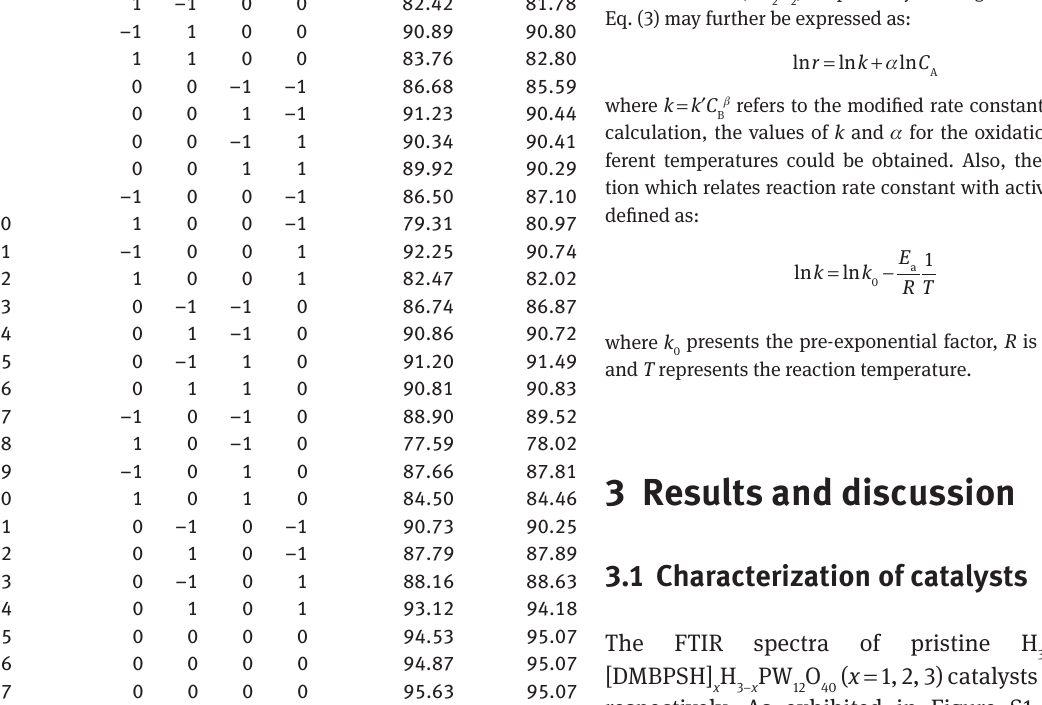
PW O catalyst. 2 12 40